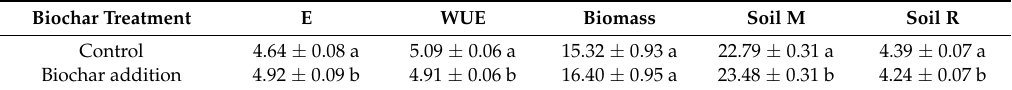
Table 2. Multiple comparisons of switchgrass leaf transpiration (E, mmol H 2 O m − 2 s − 1 ), water use efficiency